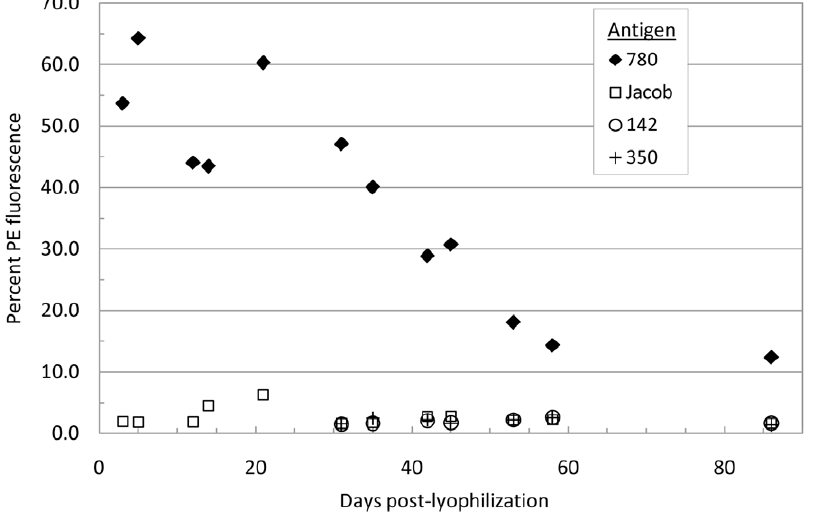
Figure 5. Lyophilization time course assay with yeast-scFv clone 780-23. One aliquot of lyophilized yeast was removed at intervals over the course of 86 days and stained first for c- myc -FITC expression followed by staining with cognate 780-biotin or three non-cognate antigens (Jacob- biotin, 350-biotin, or 142-biotin plus a no antigen control). Following detection of antigen binding with SA-PE, the percent of PE-positive yeast were determined using the no antigen stain as a gating reference. The graph depicts the percent positive yeast ( y -axis) at each of the time points tested ( x -axis) for each of the four antigens. The assay was terminated when binding to cognate 780-biotin antigen had dropped below 15%.